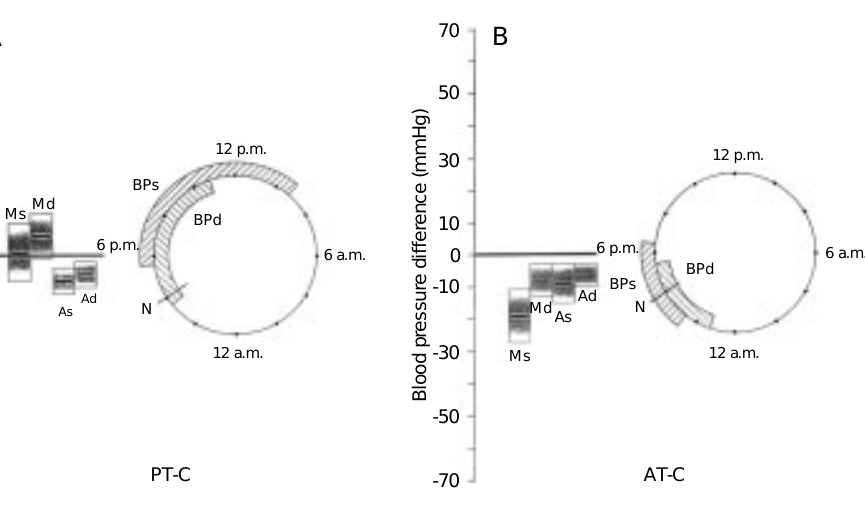
tween treated Cushing’s syn- drome due to adrenal adenoma (AT) and controls